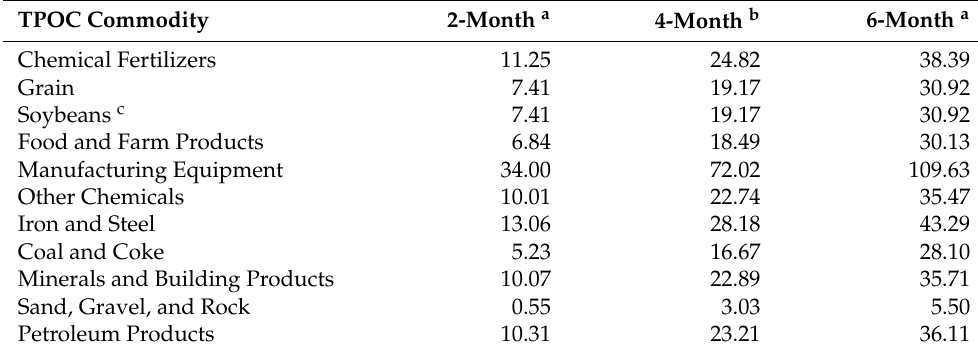
Table 3. Costs by Commodity and Length of Disruption ($ per tonnage).